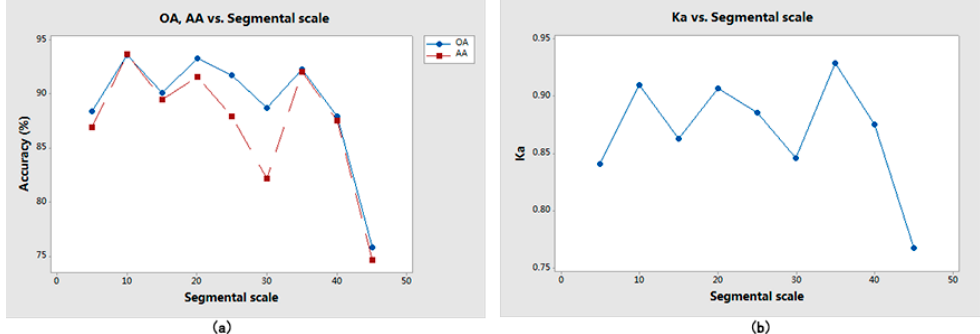
Figure 9. Relationship between segmental scale and accuracy: ( a ) OA, AA vs. segmental scale; ( b ) Ka vs. segmental scale.